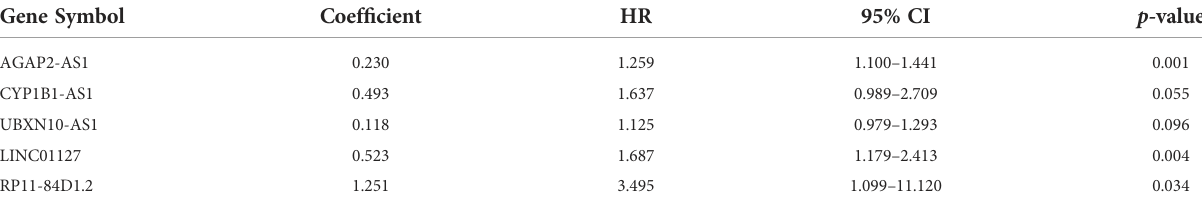
TABLE 1 Multivariate Cox regression analyses of the fi ve immune-related lncRNAs associated with overall survival in GBM. Gene Symbol Coef fi cient HR 95% CI